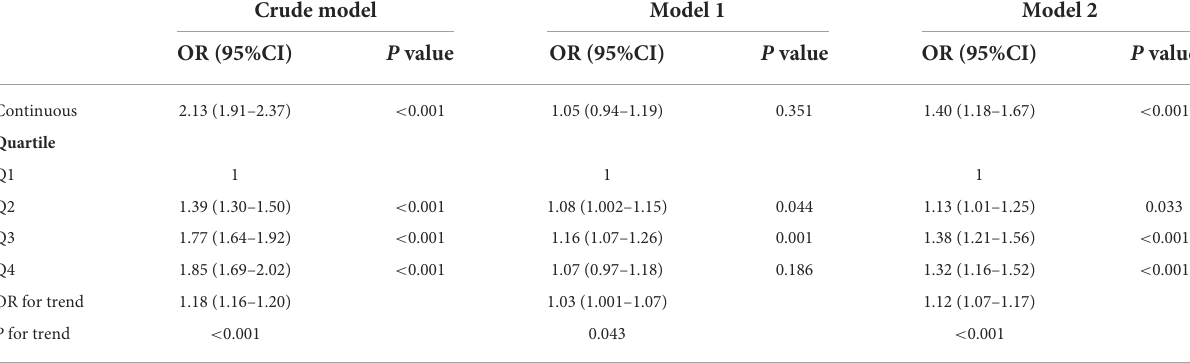
TABLE 5 Association between blood Pb and hyperlipidemia including pregnant women among US adults in NHANES